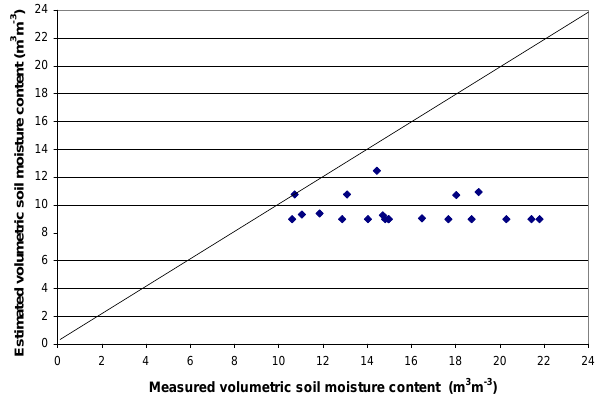
Fig. 3. Scatter plot of volumetric soil moisture content measured and estimated by MDM.